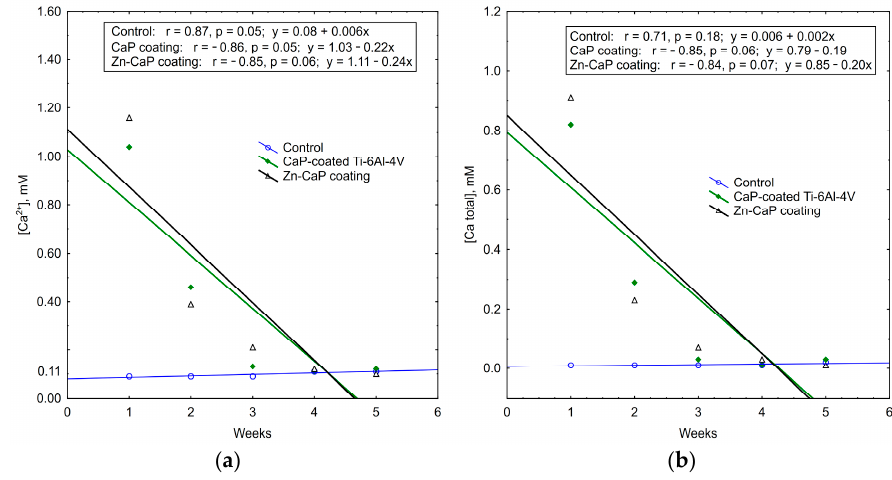
Figure 12. Regression lines of ( a ) Ca 2+ and ( b ) Ca total median concentration in weekly extracts during 5-week immersion of Ti–6Al–4V substrates with different CaP coatings in 0.9% NaCl solution.